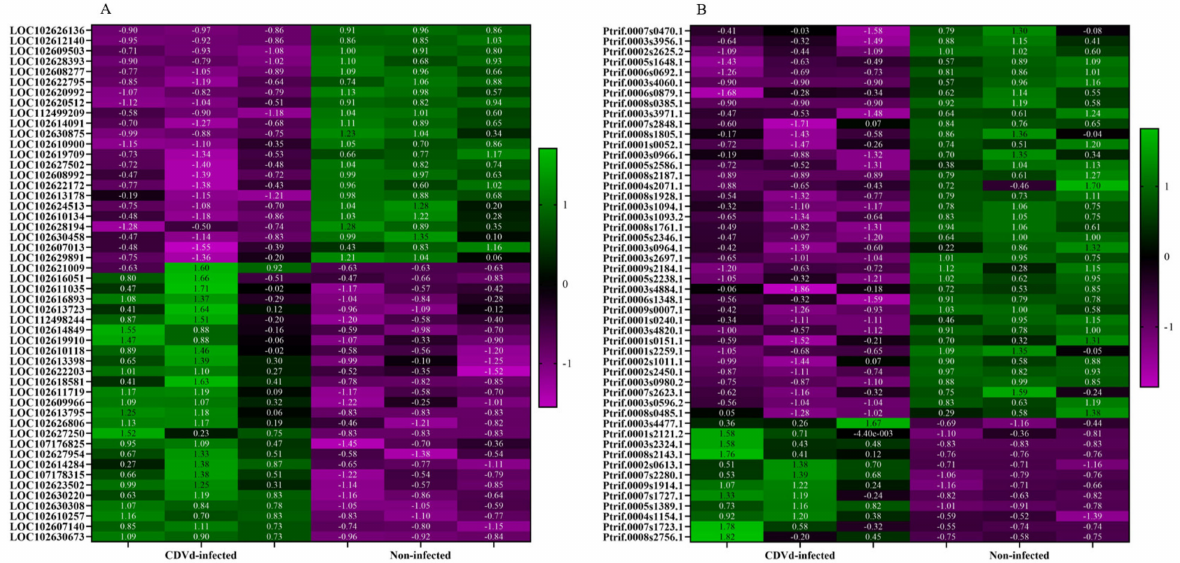
Figure 4. Heat map of the top 50 differentially expressed genes (DEGs) in both ( A ) stems and ( B ) roots ranked by FDR. The targets indicated in green are upregulated DEGs, while magenta targets are downregulated